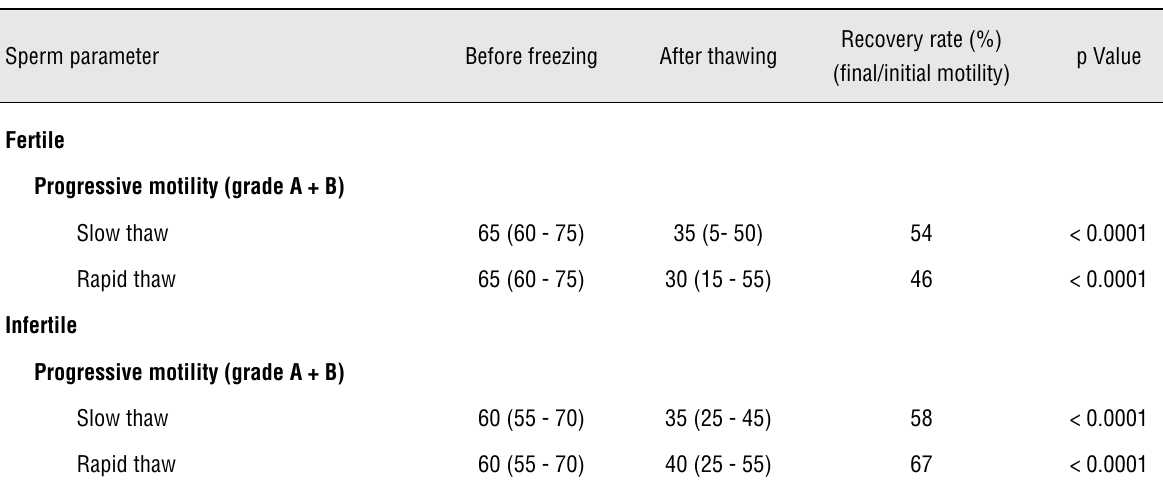
Wilcoxon test was used to analyze non-parametric paired variables progressive motility Data are expressed as median and interquartile